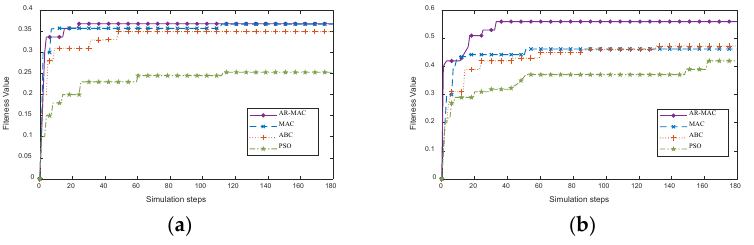
Figure 8. Fitness curve of the algorithms in two scenarios: ( a ) scenario 1, ( b ) scenario 2.